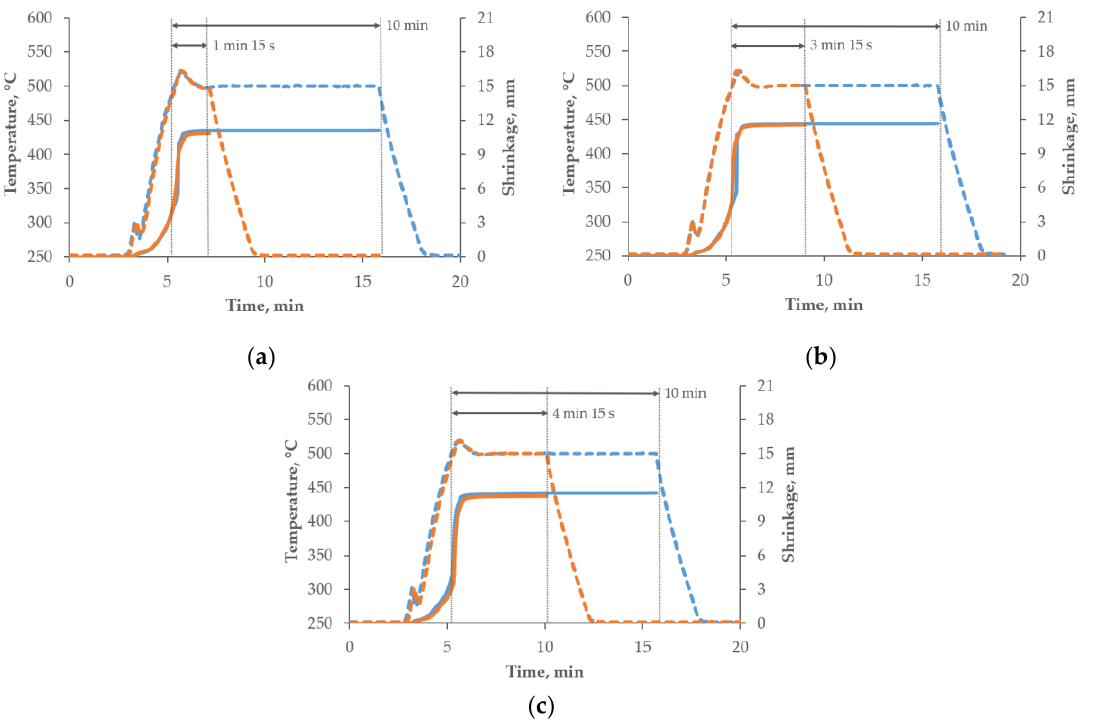
Figure 2. Shrinkage curves of ( a ) AA7075-3wt%B 4 C, ( b ) AA7075-5wt%B 4 C and ( c ) AA7075-10wt%B 4 C spark plasma sintered at various holding times (10 min: blue curve; optimized time: orange curve) marked by arrows (temperature: dotted curve; shrinkage: solid curve).